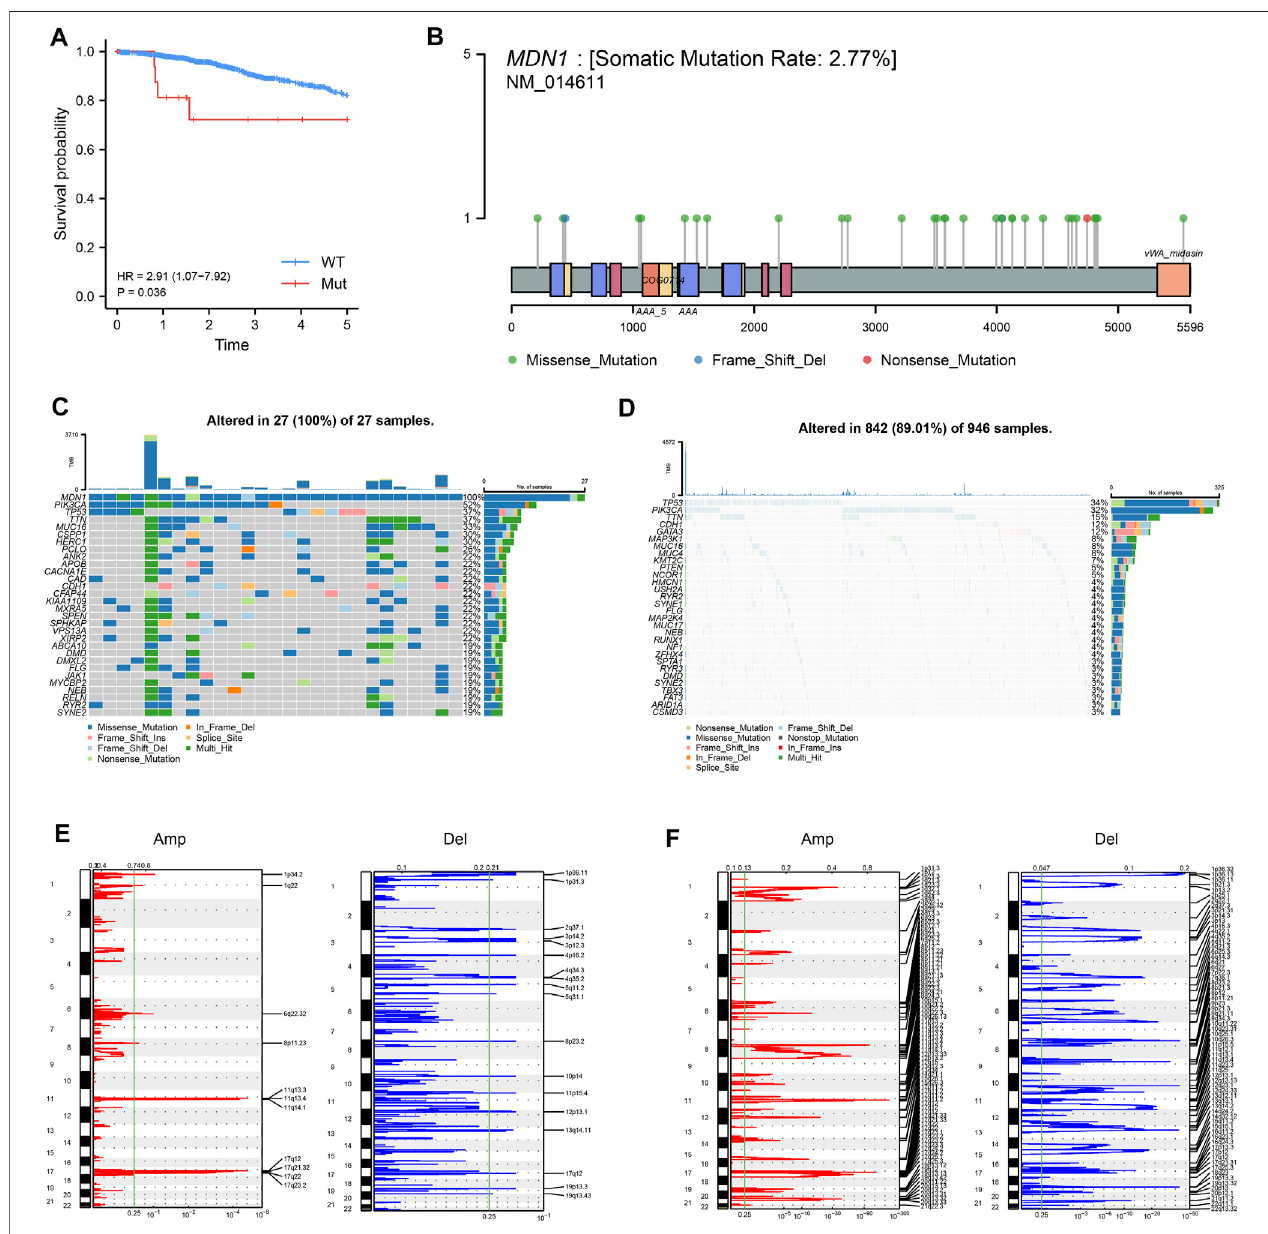
FIGURE 2 | Analysis of mutation panorama and CNV changes in the MDN1 MUT group and WT group. (A) Prognostic analysis of MDN1 mutation status in TCGA-BRCA; (B) Information regarding the MDN1 mutation sites in TCGA-BRCA; (C) Mutation genes and types in the MDN1 MUT group in TCGA-BRCA; (D) Mutation genesandtypesin theMDN1WTgroup in TCGA-BRCA; (E-F) Variation oftheMDN1copy number in mutationgroup andwild group; redrepresentsgene ampli fi cation and blue represents gene deletion.